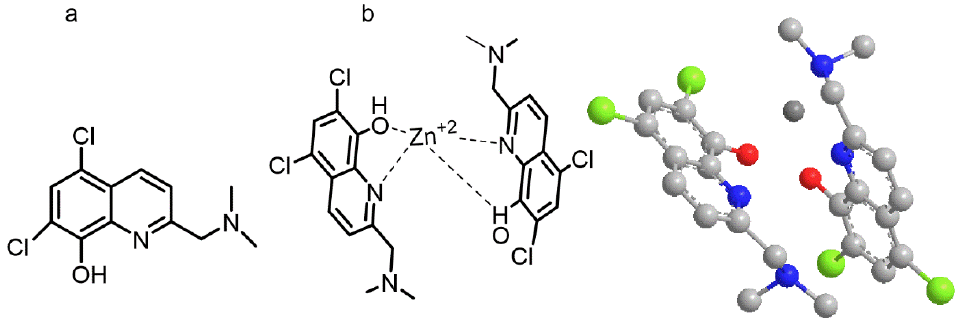
Figure 2. Structure ( a ) and three-dimensional study ( b ) of PBT2 (5,7-Dichloro-2-((dimethylamino) methyl) quinolin-8-ol). Light grey balls represent carbon atoms. Blue balls represent nitrogen atoms. Non linked dark grey balls represent zinc cations. Red balls represent oxygen atoms. Green balls represent chlorine atoms.